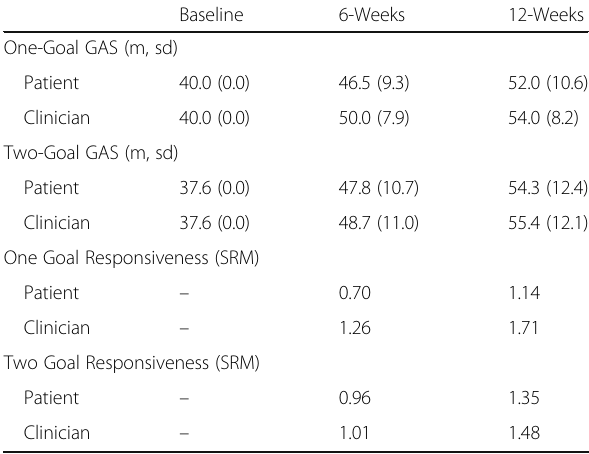
Table 2 Patient and clinician GAS scores and SRM for one-